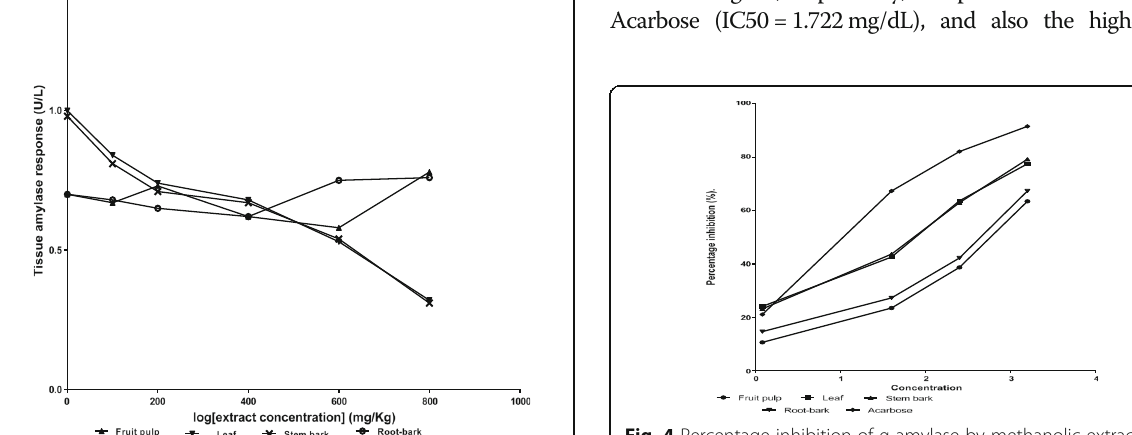
Fig. 4 Percentage inhibition of α -amylase by methanolic extract of Annona muricata fruit-pulp, leaf, stem-bark, root-bark and acarbose (reference